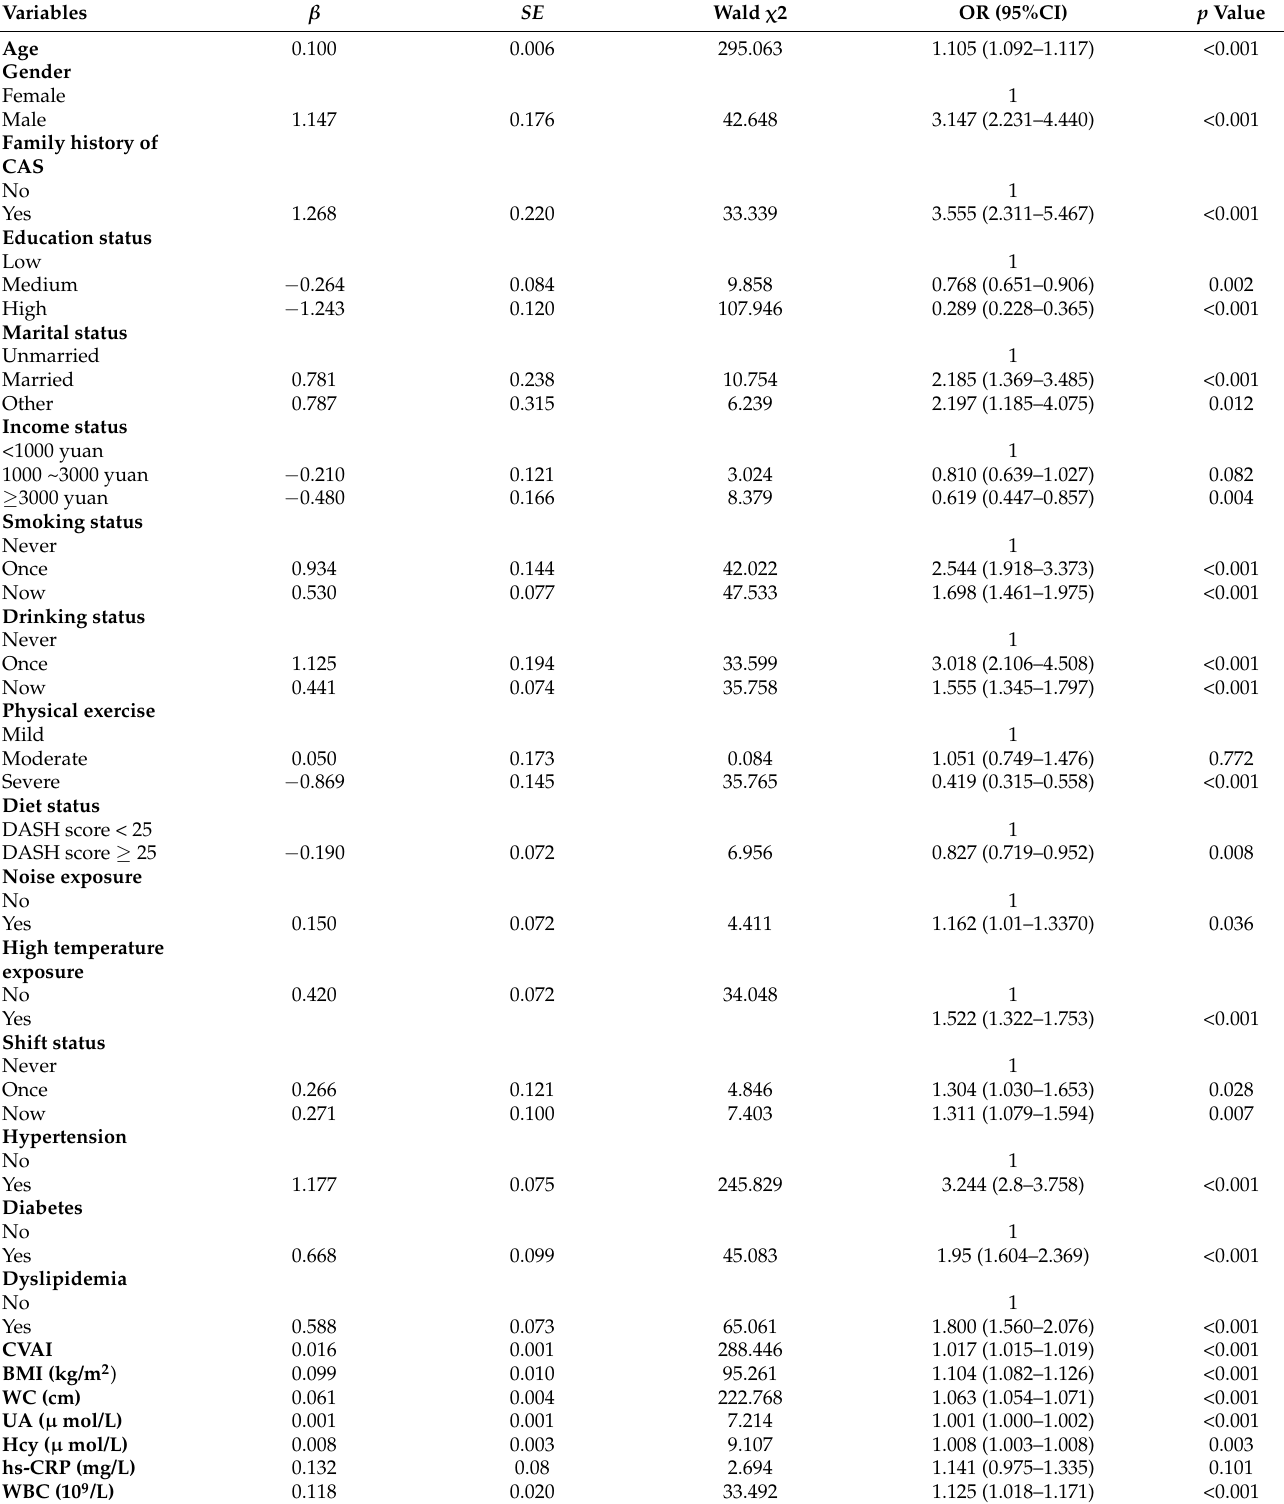
Table 2. Risk factors analysis of CAS among